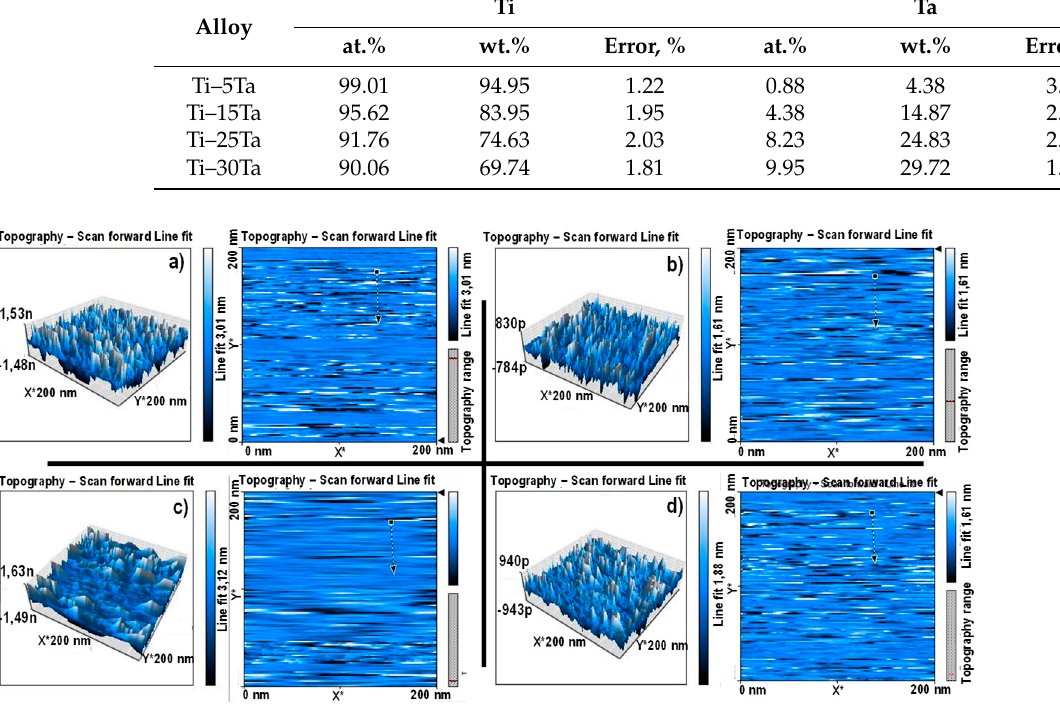
Figure 2. Representative scanning tunneling microscopy (STM) images of surface topographies for ( a ) Ti5Ta, ( b ) Ti15Ta, ( c ) Ti25Ta, and ( d ) Ti30Ta.